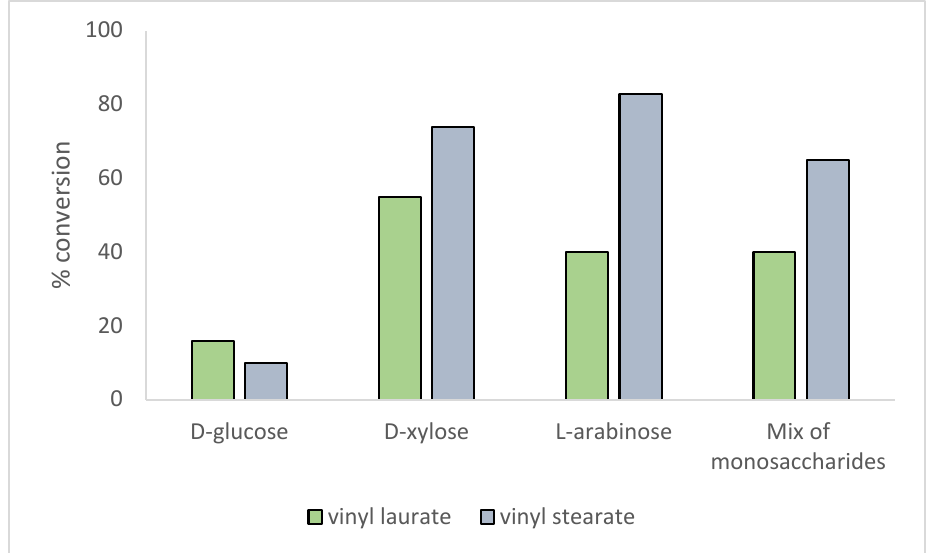
Figure 4. Conversion of D -glucose, L -arabinose, D -xylose and vinyl laurate or vinyl stearate for 24 h by Lipozyme RM IM. Data are shown as the averages of duplicate experiments.